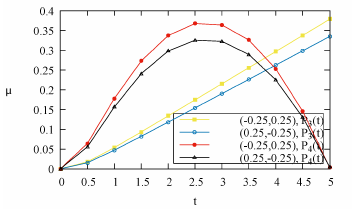
Figure 10. Solution µ at points ( − 0 . 25 , 0 . 25) , (0 . 25 , − 0 . 25) for Problem 2 of anisotropic homogeneous